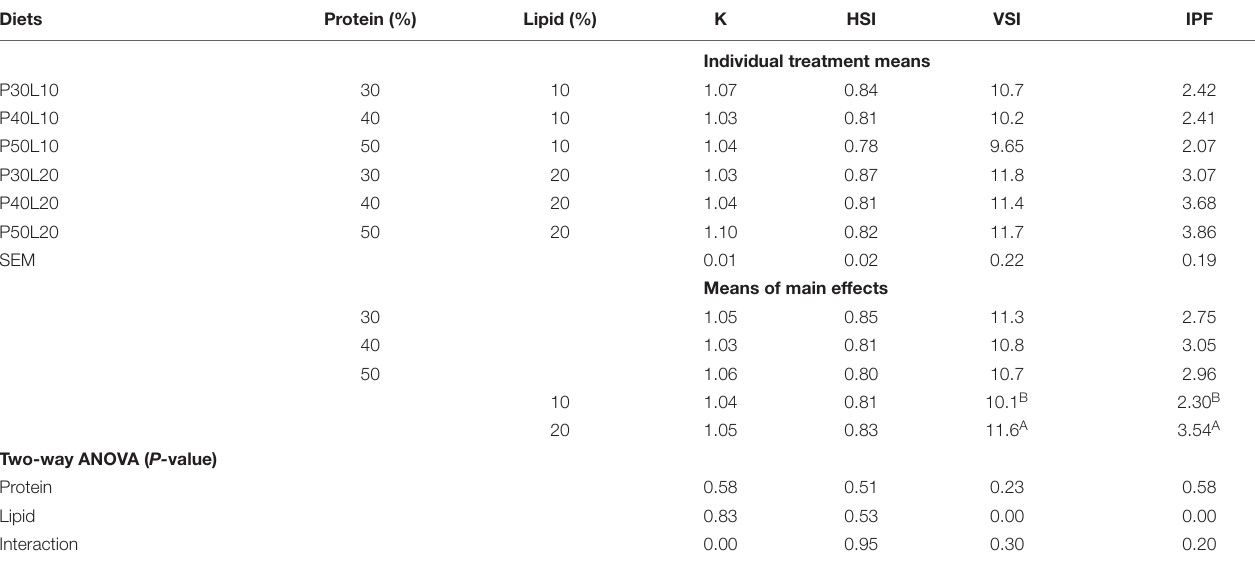
Values are mean of triplicate groups (n = 30). Different superscript letters indicate significant difference among treatments (P < 0.05). K, Fulton’s condition factor = Body weight × 100/(Body length) 3 : HSI, Hepatosomatic index = Liver weight × 100/fish weight: VSI, Viscerosomatic index = Viscera weight × 100/fish weight: IPF, Intraperitoneal fat ratio = Intraperitoneal fat weight × 100/fish